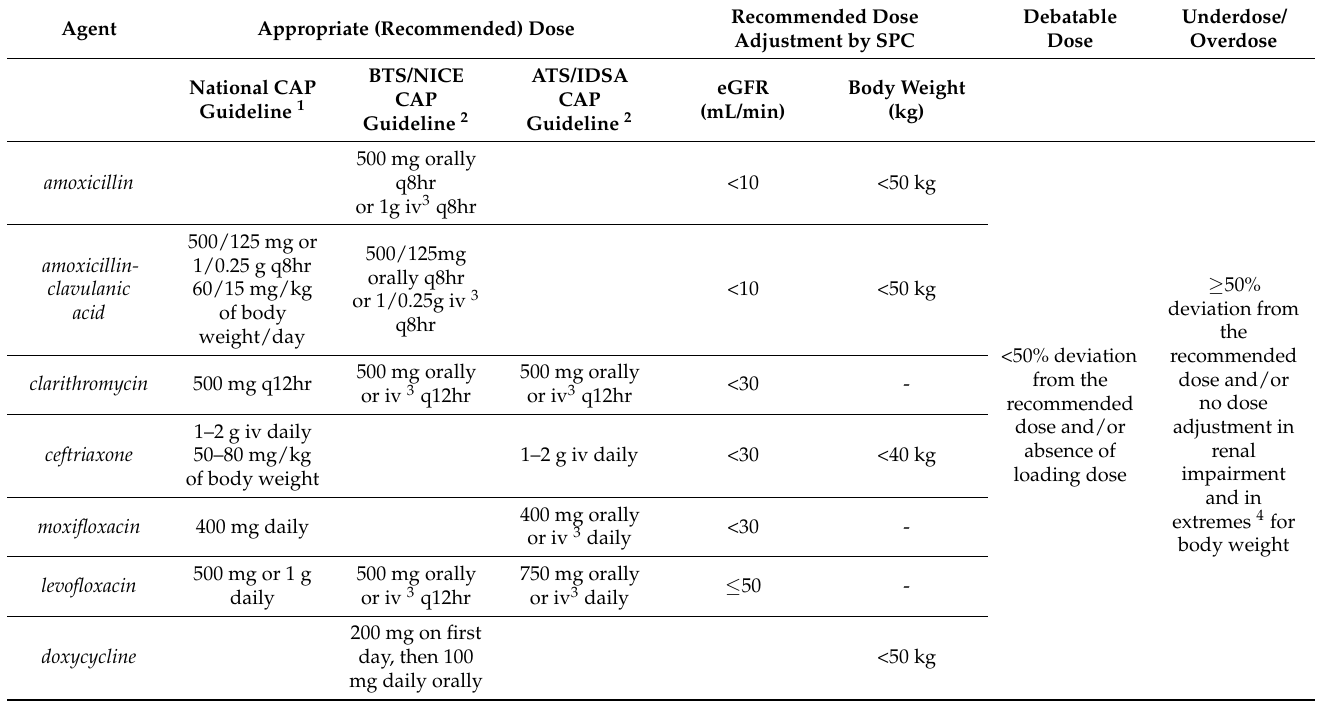
Table A1. Dosage assessment